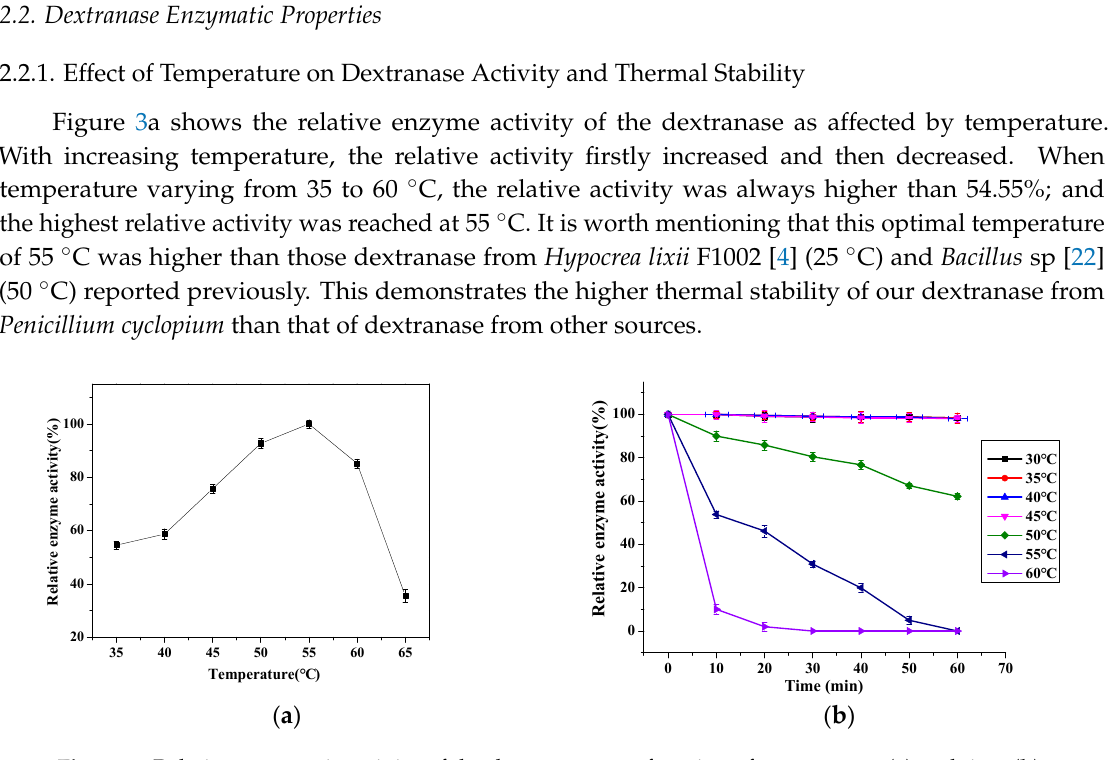
Figure 3. Relative enzymatic activity of the dextranase as a function of temperature ( a ) and time ( b ).